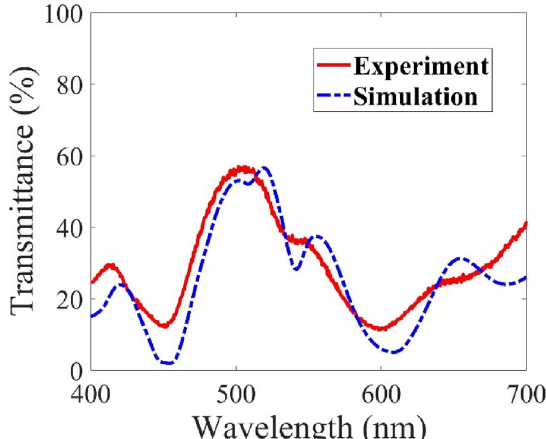
Fig. 5 Transmission characterization of the fabricated metalens. Comparison of simulated and measured transmittance spectra of the metalens